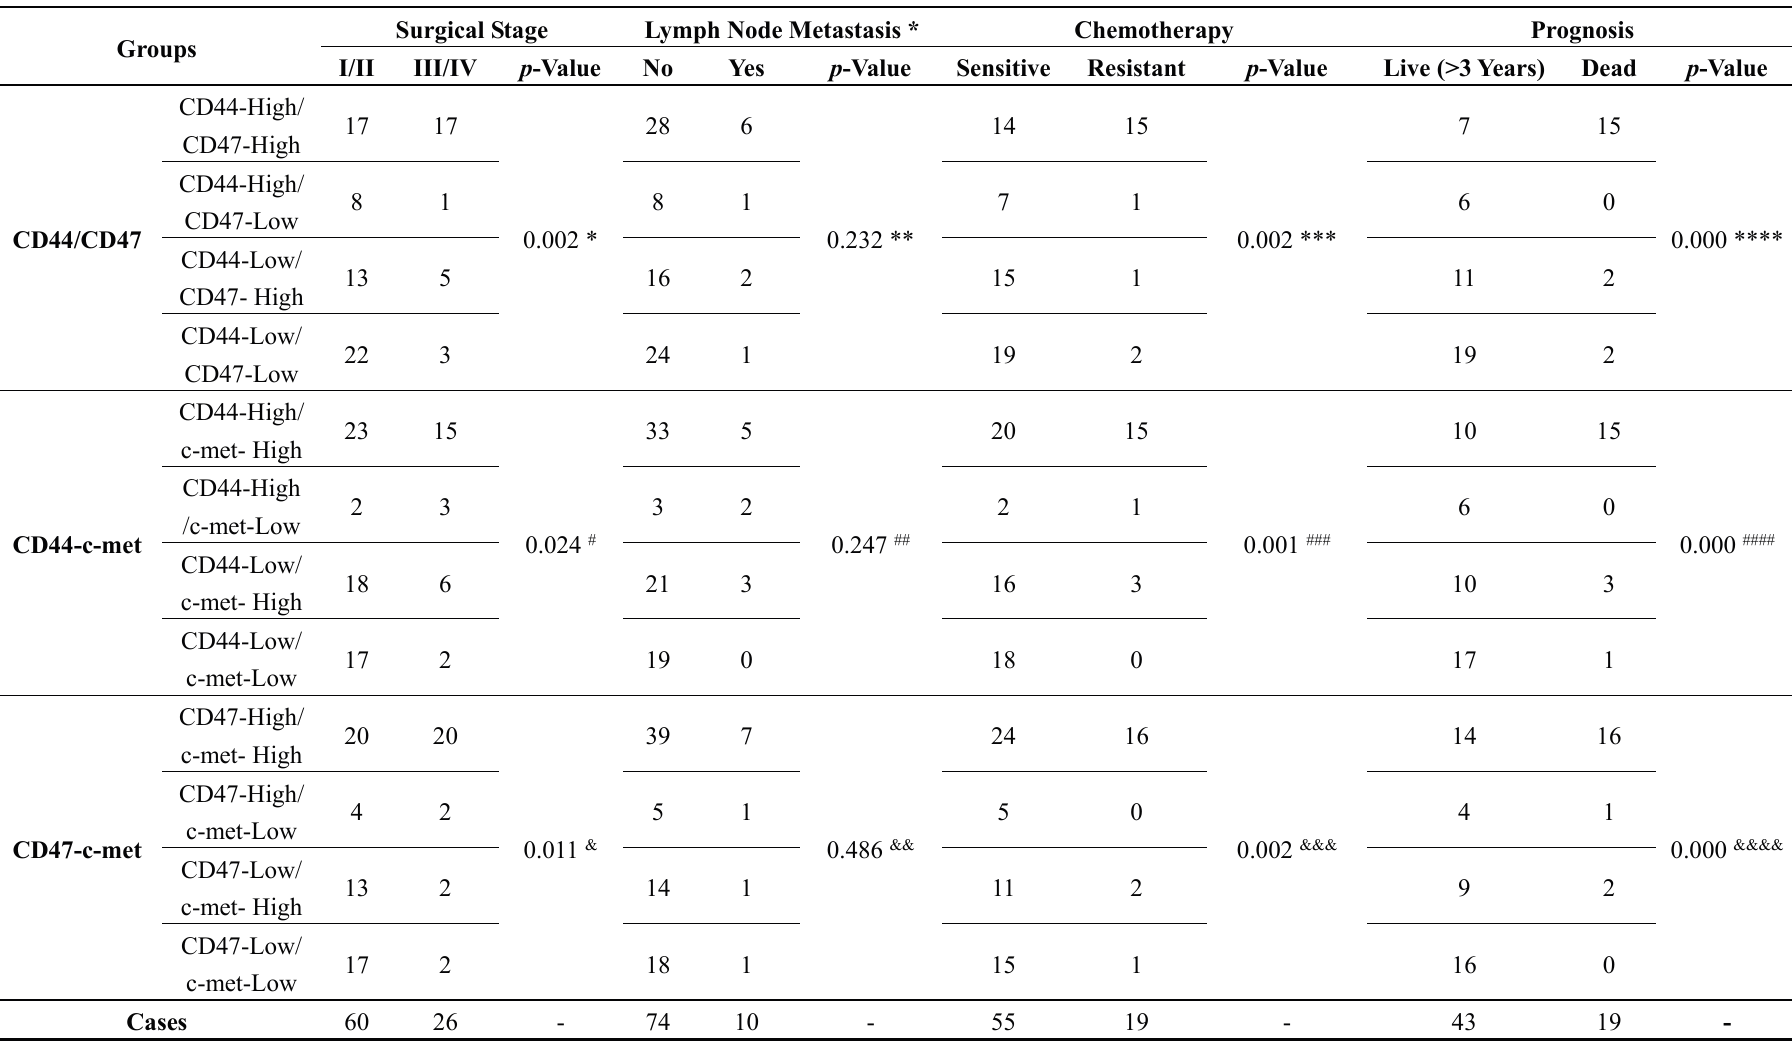
Table 5. Relationship between CD44/CD47, CD47/c-met and CD47/c-met levels and the clinicopathological features and prognosis of OCCC.